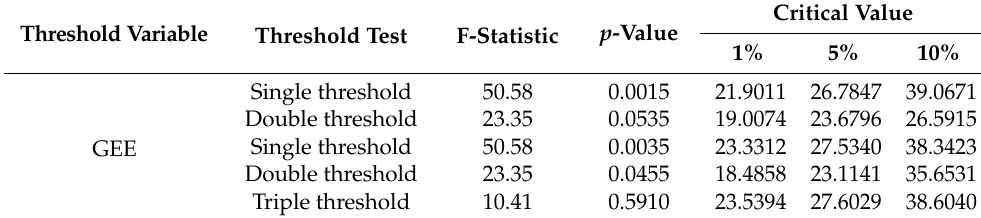
Table 7. Threshold test results of green energy